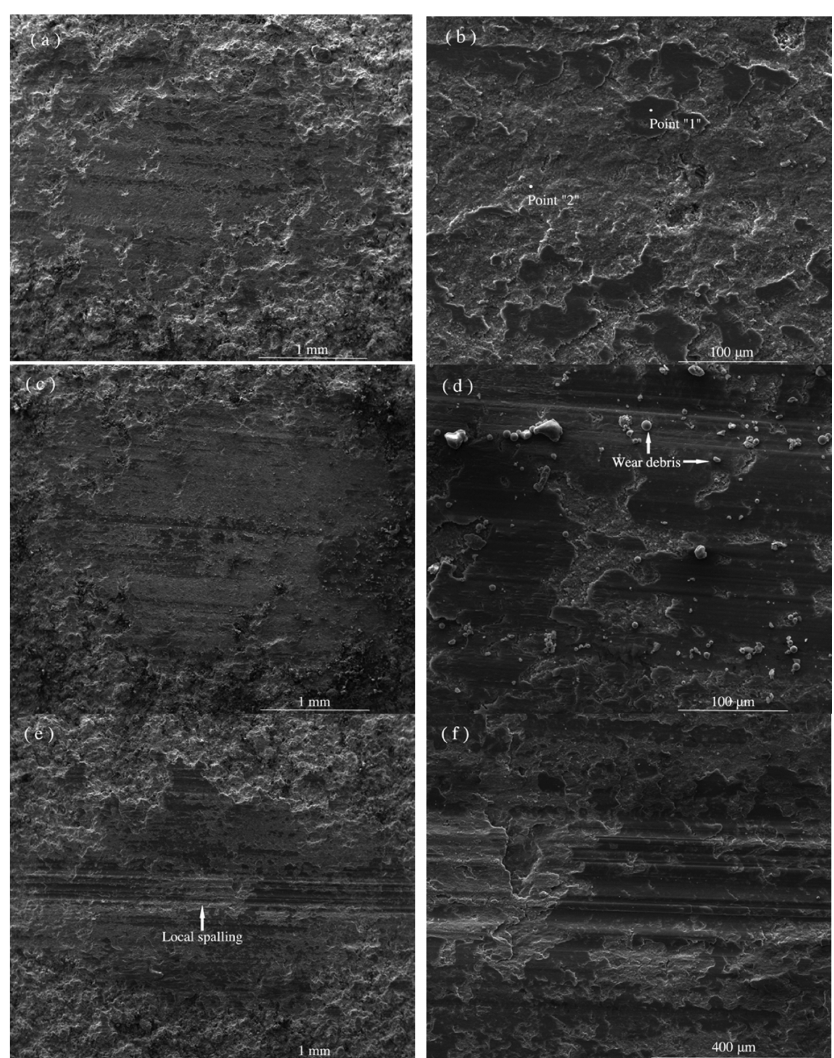
Figure 11: Worn surface morphologies of GQ-MC (a-b) 50N, (c-d) 100N, (e-f) 200N.